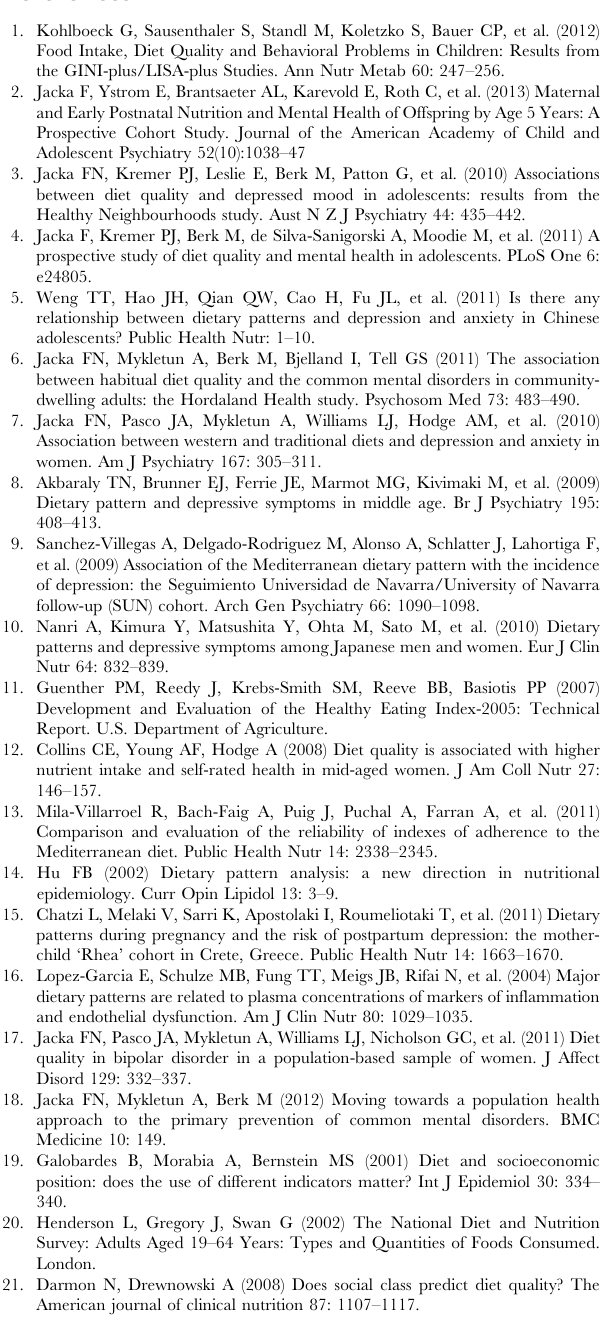
Table S1 Rotated factor scores for prudent and western dietary